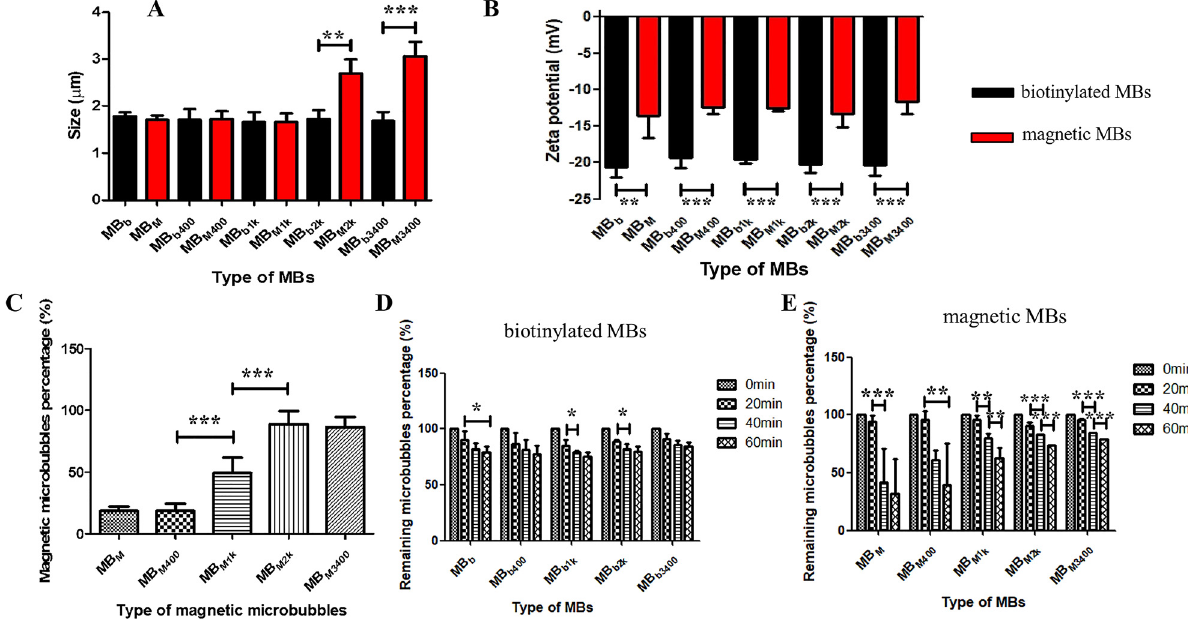
Figure 4: (A) The average particle size and (B) zeta potential of biotinylated MBs and the generated magnetic MBs with different PEG chain lengths; the black and red bars represent biotinylated MBs and magnetic MBs, respectively. (C) The percentage of magnetic MBs obtained in the total MB population. The remainingproportion of (D) biotinylated MBs and (E) magnetic MBs in the total MBs measured immediately after preparationandafterstorageinPBSunderambientconditionsfor20,40,and60min.DatarepresentmeanwithSD, n =5.* p <0.05,** p <0.01, *** p < 0.001.